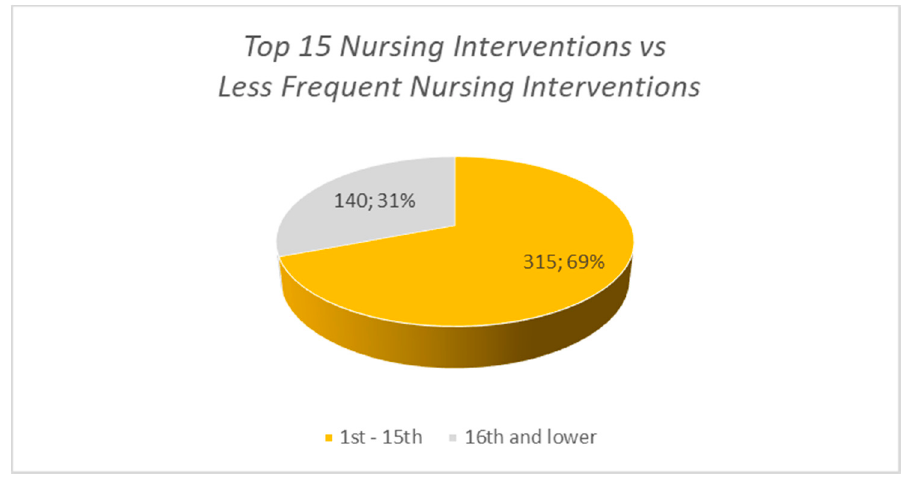
Figure 2. Distribution of the top 15 nursing interventions versus the total number of registered nursing interventions.